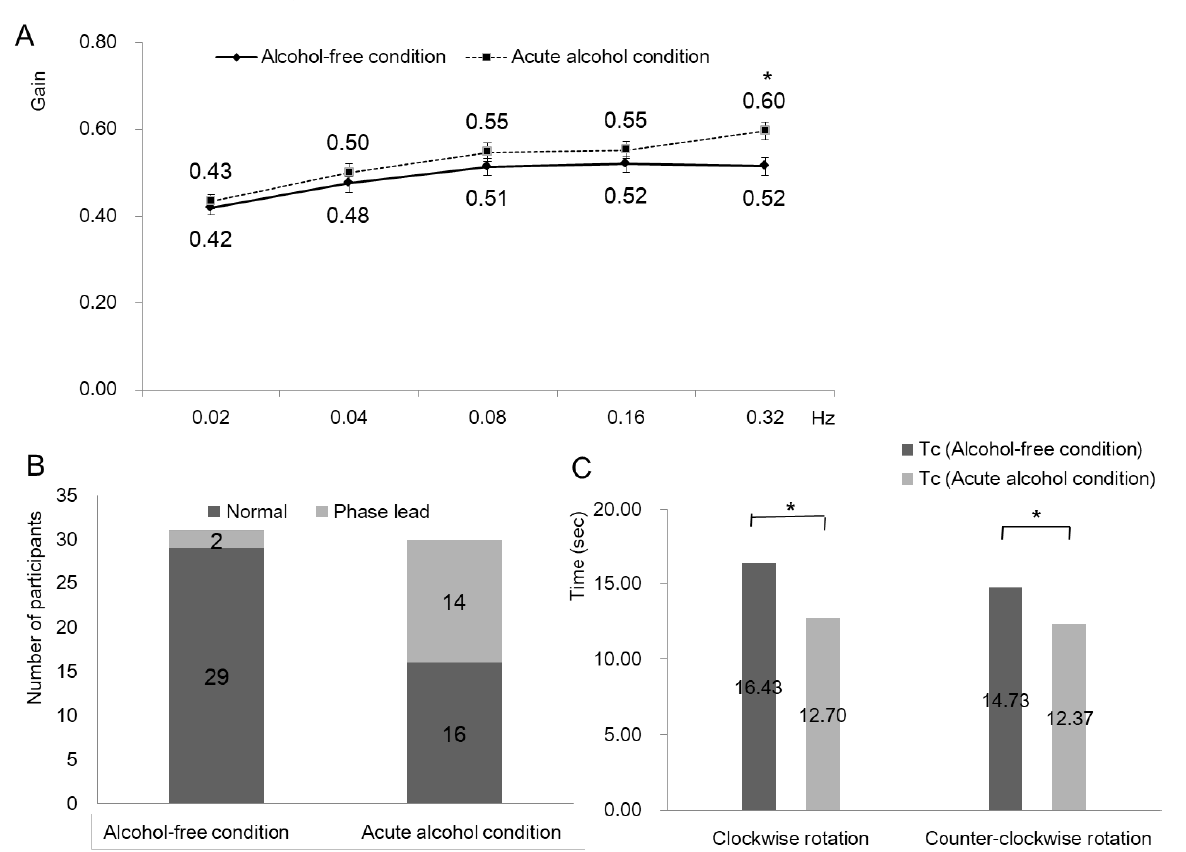
Figure 1. Effect of alcohol on mid-frequency VOR and time constant. ( A ) In the SHA test, VOR gains were not different in healthy condition and in acute alcohol condition in most frequencies. However, in 0.32 Hz sinusoidal rotation, VOR gain increased from 0.52 ± 0.02 to 0.60 ± 0.02 after acute alcohol intake ( p = 0.008). ( B ) The number of participants with phase lead increased after al- cohol consumption, but the change was not statistically significant ( p = 0.209). ( C ) In step velocity test, time constants reduced significantly after alcohol intake in both clockwise (from 16.43 ± 6.80 s to 12.70 ± 3.06 s; p = 0.008) and counter-clockwise rotation (from 14.73 ± 4.31 s to 12.37 ± 2.95 s; p = 0.003). * Significance at p < 0.05 after false discovery rate adjusted. 3.5. SVV/SVH Not Affected by Alcohol Intake Acute alcohol intake did not affect the perception of verticality (Table 3). Averaged angle differences increased in both measures but were not statistically significant. Table 3. Changes in the perception of verticality in alcohol-free and acute alcohol conditions. Test